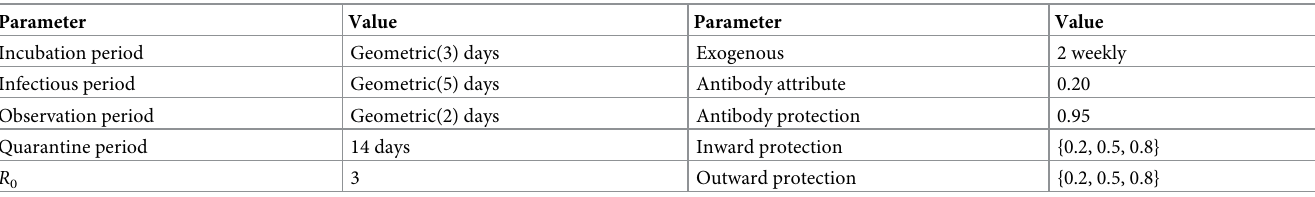
Table 1. Infection